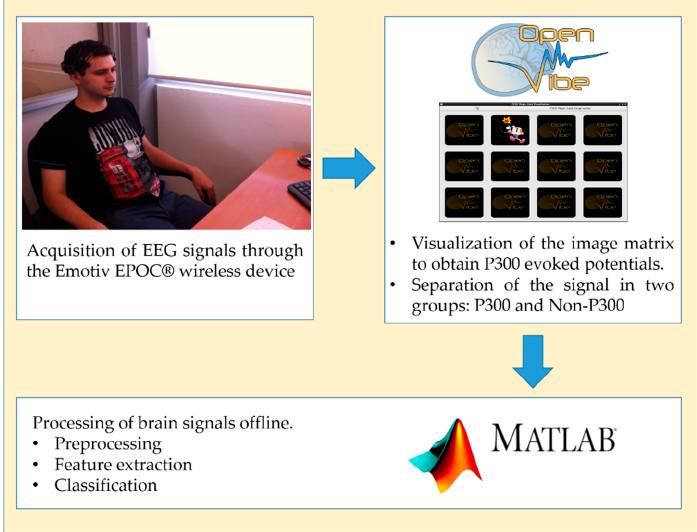
Figure 3. Complete process of the BCI System.